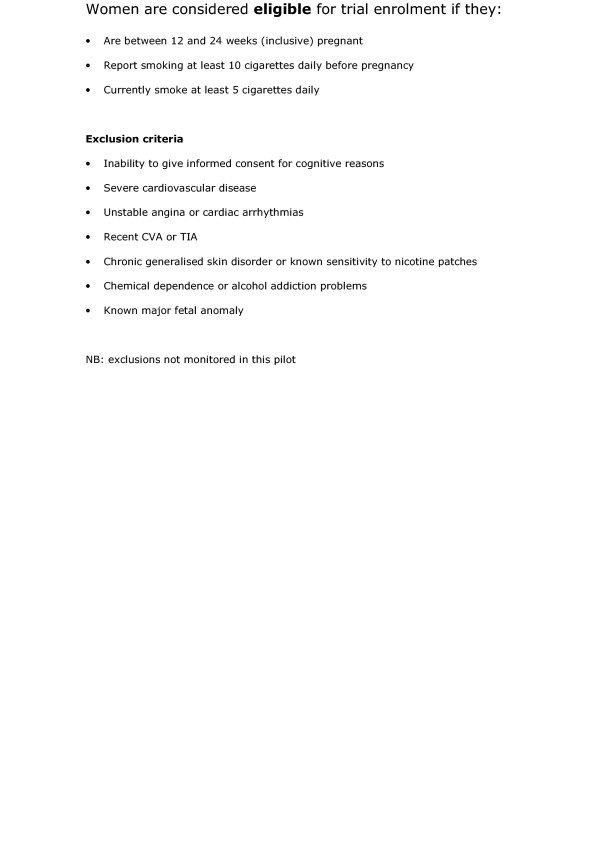
Eligibility criteria for proposed RCT